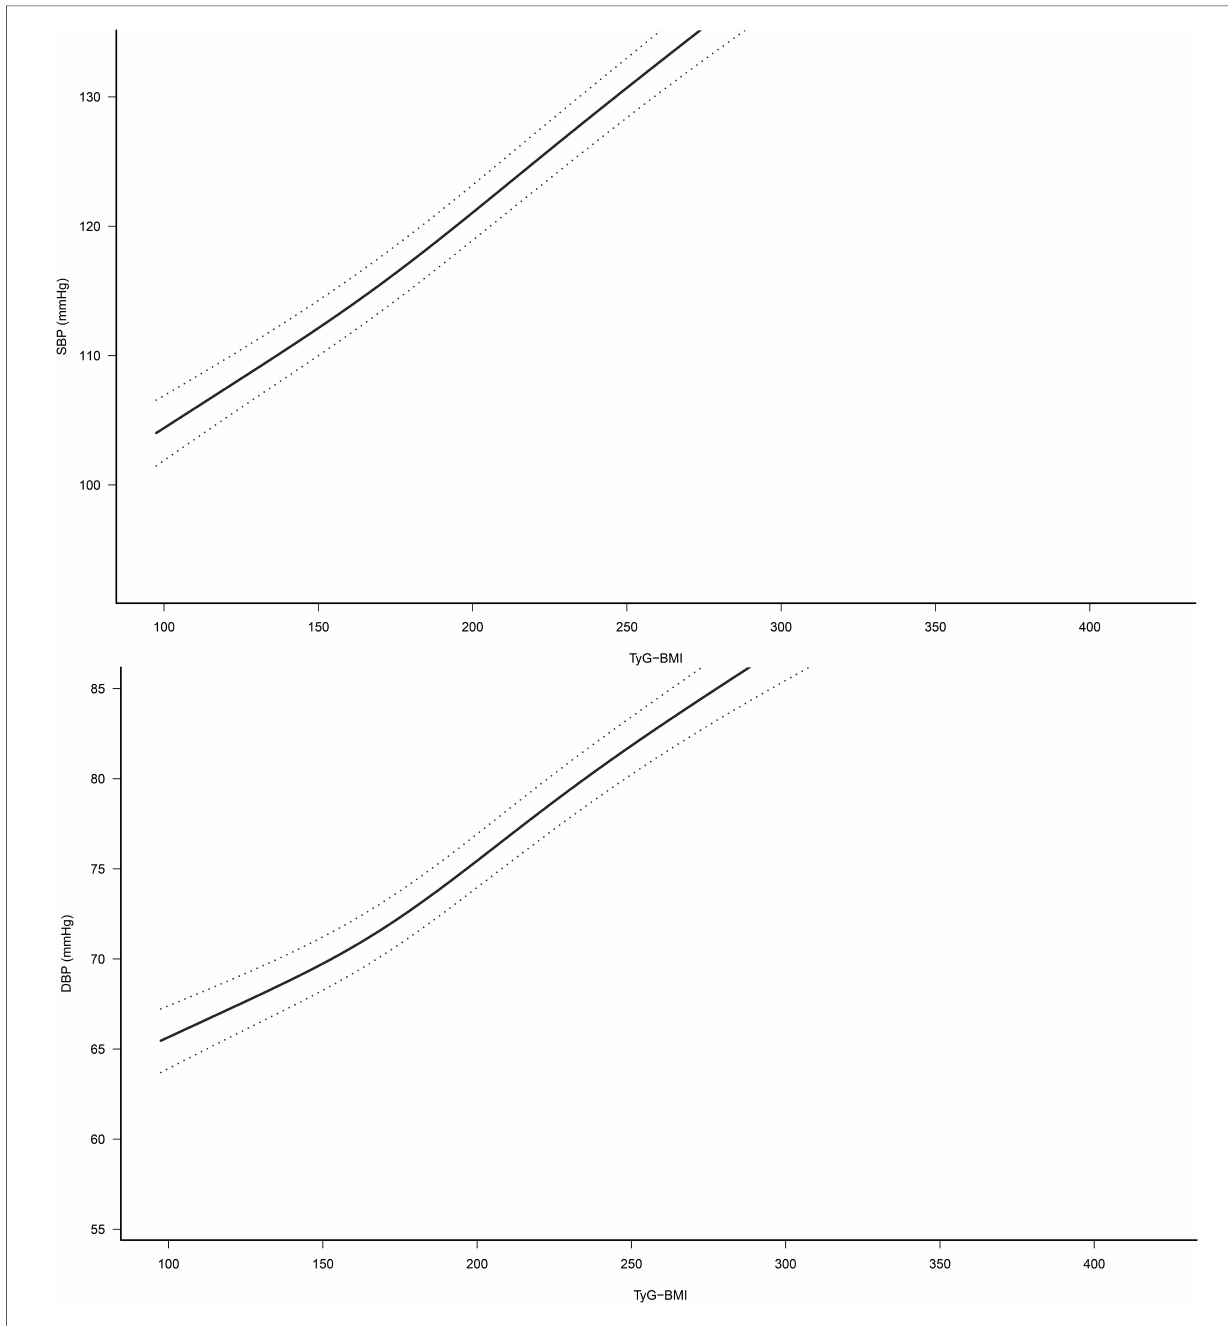
FIGURE 2 Dose-response relationship between TyG-BMI and SBP/DBP (95% con fi dence interval was shown by dashed line). Adjusted for sex, age, height, fatty liver, habit of exercise, drinking status, smoking status, HDL-C, TC, TG, HbA1c, FPG, ALT, AST and GGT. TyG-BMI, triglyceride glucose-body mass